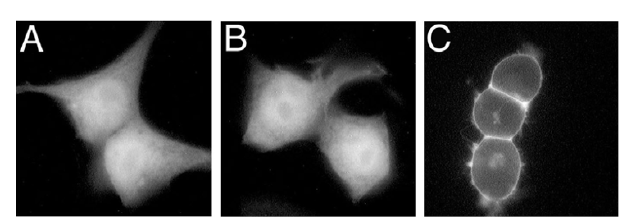
Figure 5 C-terminal 35 amino acids of s α i2 do not affect GFP localization Expression vectors encoding GFP (A), GFP- s α i2 35aa (B), or α i2 (1-10)-GFP (C) were transfected into HEK293 cells. 48 h after transfection, cells were fixed on coverslips, and subcellular localization was determined by flu- orescence microscopy visualization of GFP.